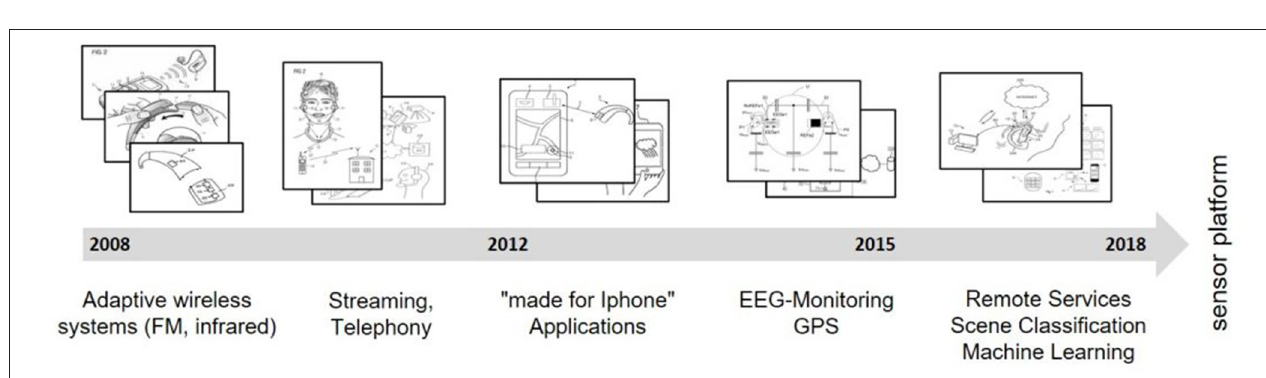
FIGURE 2 | Identification and categorization of user preferences according to their statements in the interview series.